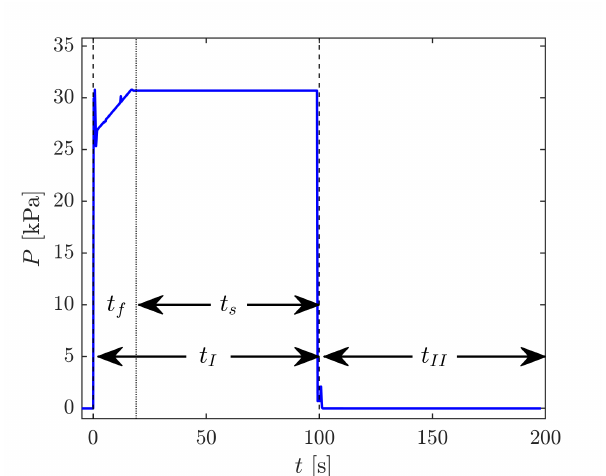
Figure 6. The time evolution of the pressure assessed in the SOP during the 200 s long gas modulation cycle displayed in Figure 5, P ( t ) . t I represents the time of filling and t II the time of evacuation during the modulation cycle, here set to 100 and 100 s, respectively. t f is the time at which the MFC was re- filling the DWPG, and t s is the time during which the DWPG was stabilizing the pressure (i.e., when the piston was